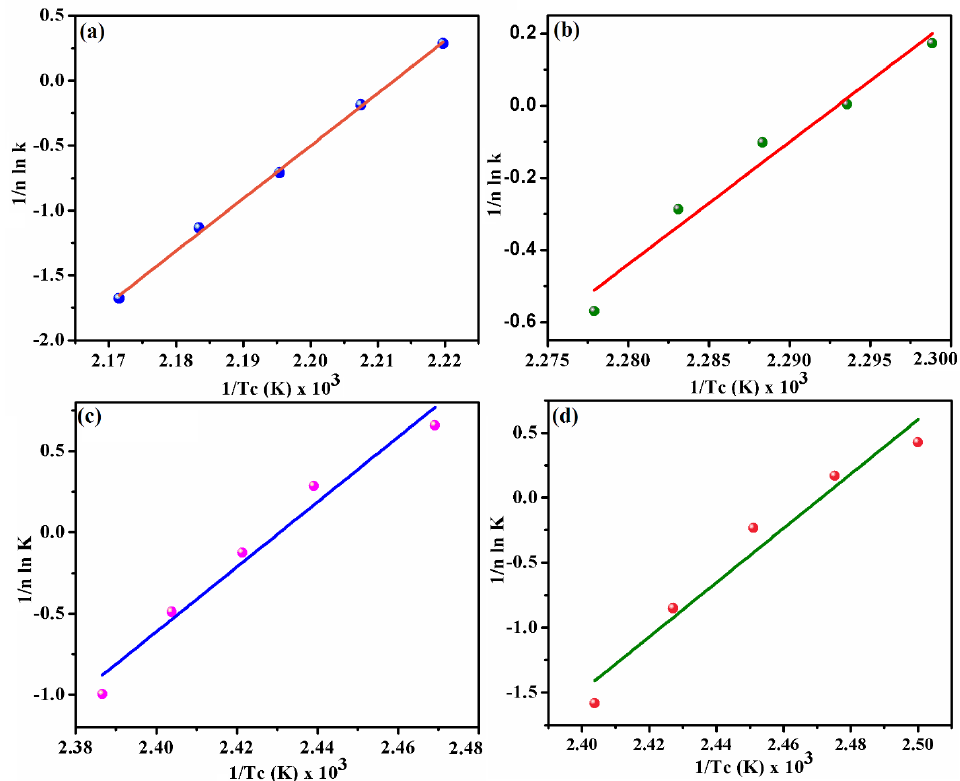
Figure 9. Activation energy for isothermal crystallization of ( a ) virgin PA6, ( b ) PA6-BABA/SA 30 , ( c ) PA6-BABA/SA 50 , and ( d ) PA6-BABA/SA 70 at various crystallization temperatures.